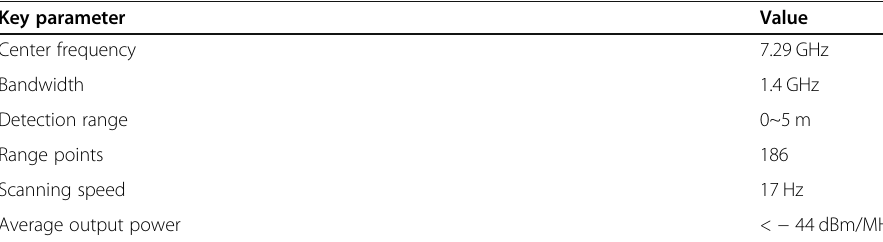
Table 1 Key parameters of the utilized UWB radar Key